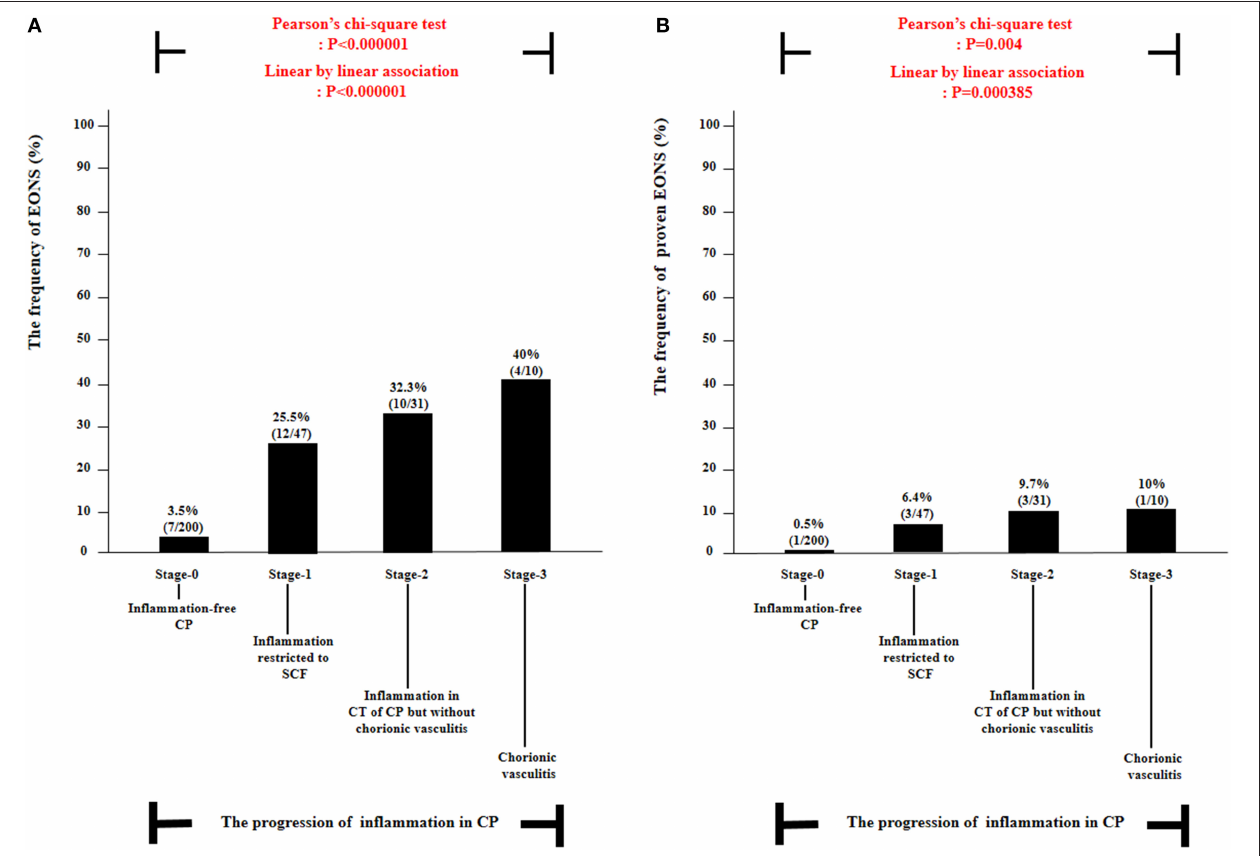
FIGURE 3 | The frequency of suspected or proven early-onset neonatal sepsis (EONS) (A) and proven EONS (B) according to the progression of inflammation within chorionic plate (CP) [i.e., stage-0, inflammation-free CP vs. stage-1, inflammation restricted to subchorionic fibrin (SCF) vs. stage-2, inflammation in the connective tissue (CT) of CP without chorionic vasculitis vs. stage-3, chorionic vasculitis] among preterm gestations. Each P -value is shown in the graph. Twenty-one neonates were excluded from the analysis of suspected or proven EONS among 309 cases because they died shortly after delivery as a result of extremely prematurity ( n = 11) or had no information about EONS in the medical records ( n = 10) and thus could not be evaluated with respect to the presence or absence of